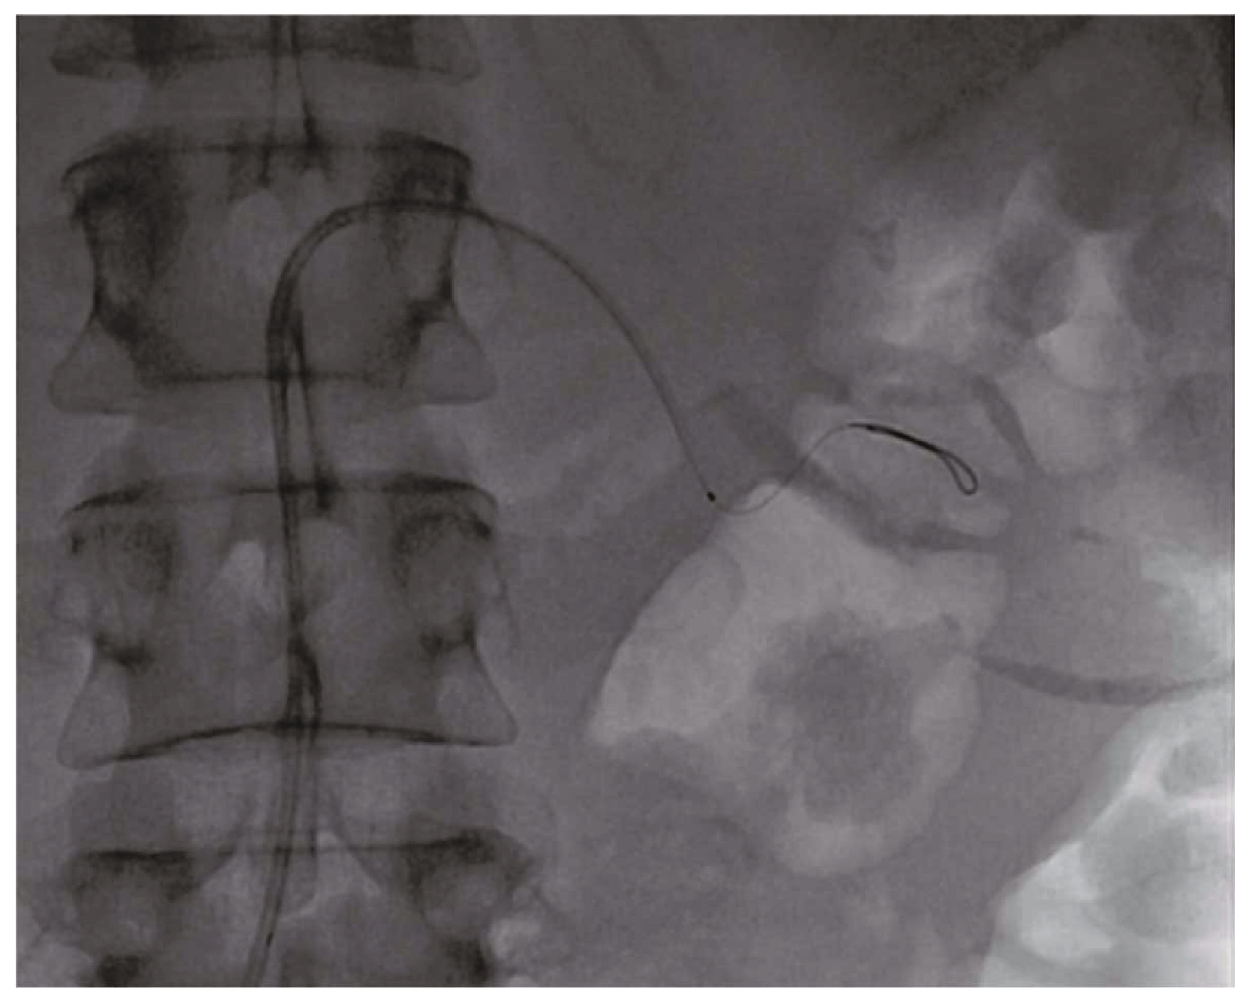
Figure 4: Aspiration thrombectomy catheter taken down multiple interlobar